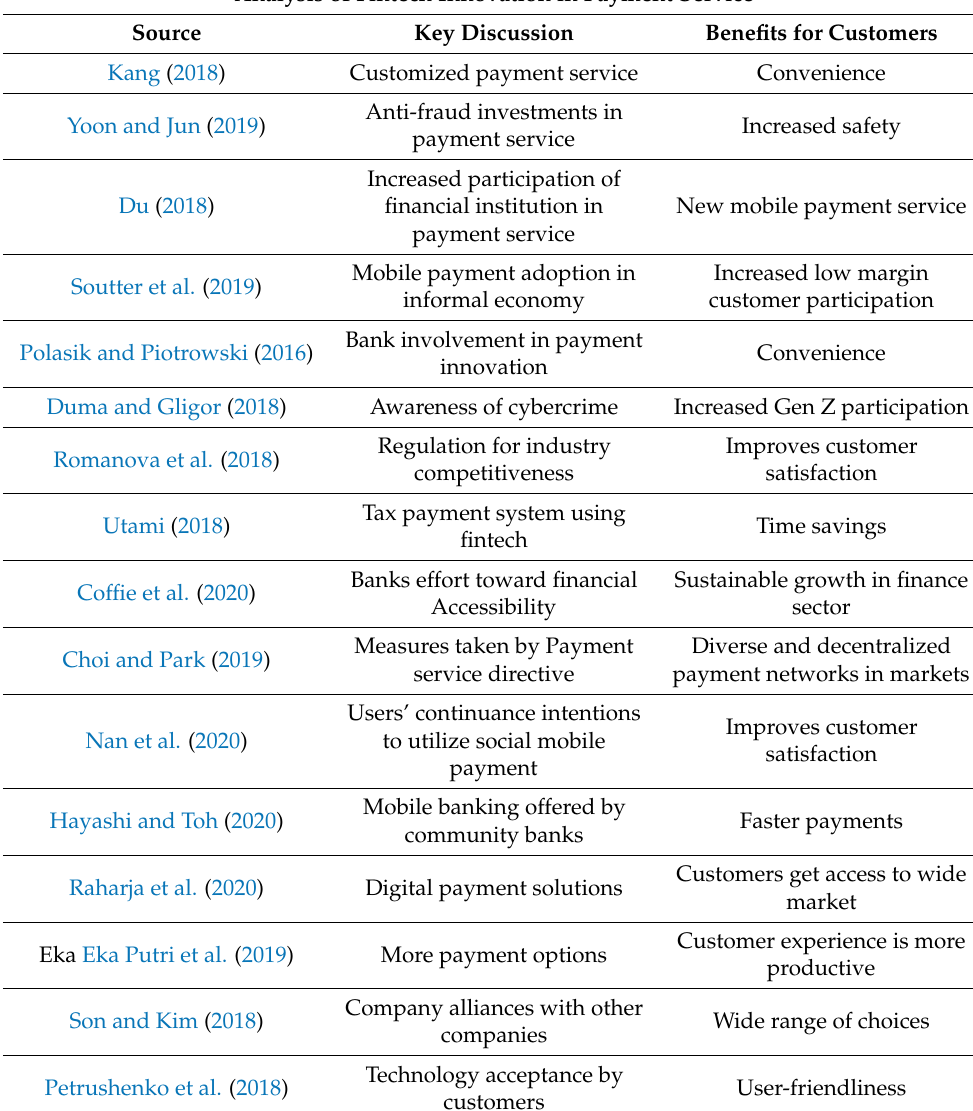
Table 1. Analysis of fintech innovation in payment